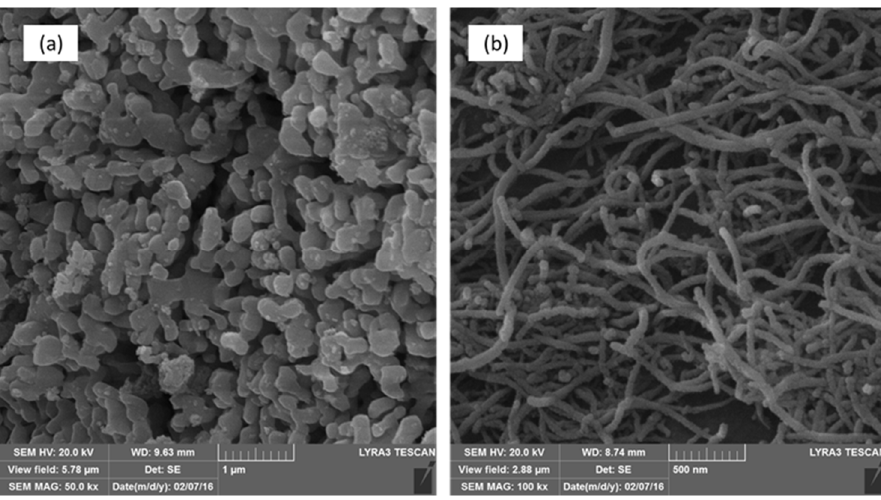
Figure 3. FE–SEM images of as-received ( a ) α -alumina and ( b ) CNTs.